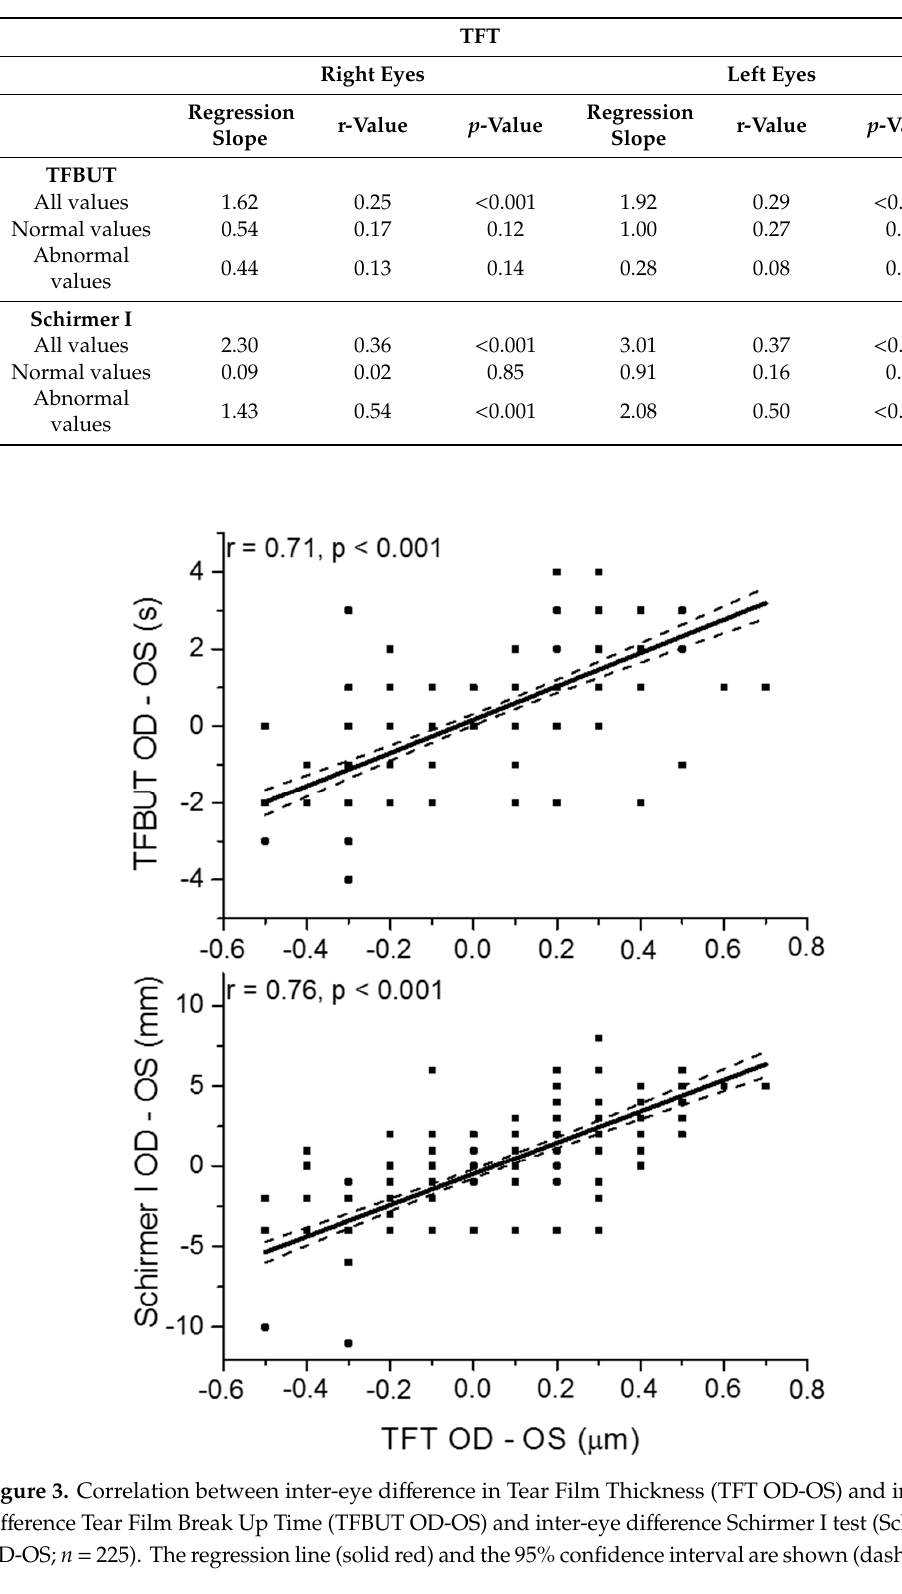
Table 2. Slope of regression line, r- and p -values between tear film thickness (TFT) as well as break up time (TFBUT) and Schirmer I test separately shown for right and left eyes.